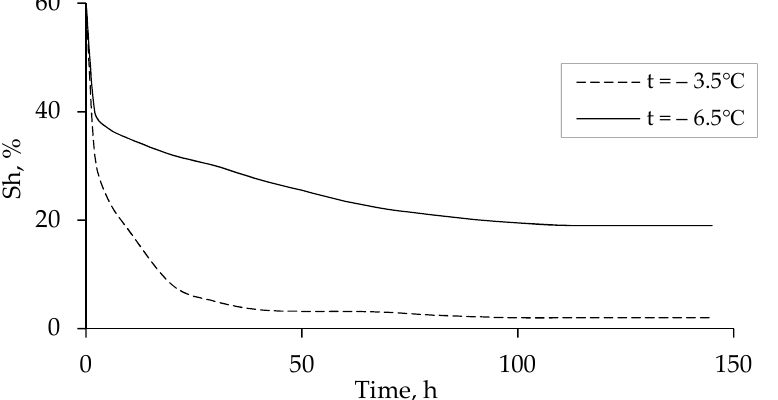
Figure 11. Time-dependent hydrate saturation in the frozen sand 2 sample (W = 18%) after the pressure dropped to 0.1 MPa at −3.5 °С and −6.5 °С.